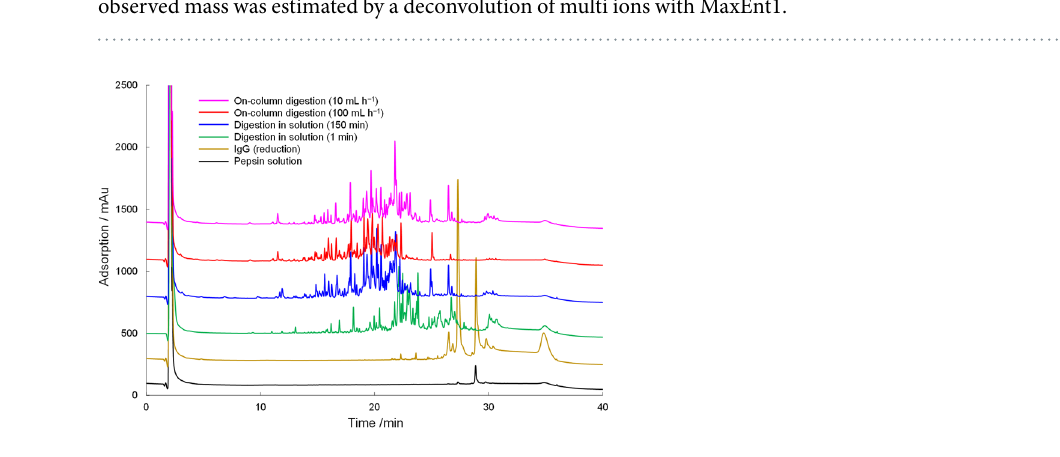
Figure 6. Online digestion of a recombinant human IgG1 antibody with the Pep-SpM. UV chromatograms of the digested antibody in solution or online with the